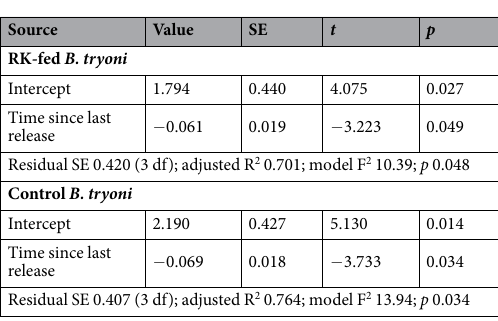
Table 1. Effect of pre-release feeding raspberry ketone to immature sterile male B. tryoni on survival in a commercial orchard. Linear regression model of log(1 + average recapture of RK fed flies or RK-denied flies)